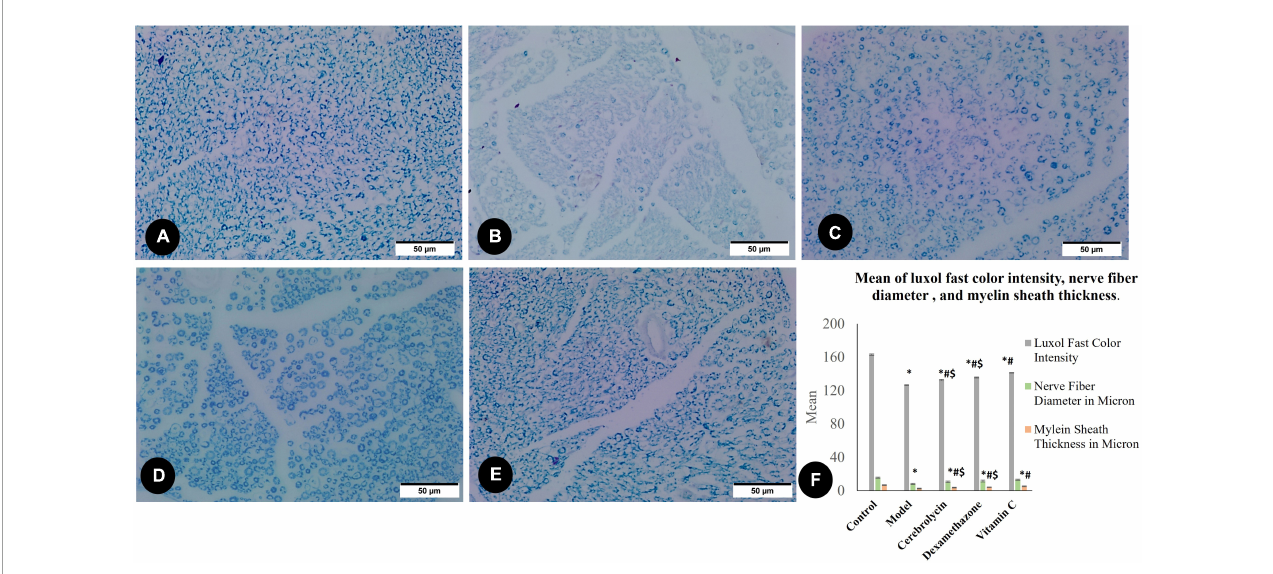
FIGURE4 Luxol fast blue staining myelin sheet in the control group (A) , the model group (B) , the Cerebrolysin group (C) , the dexamethasone group (D) , and the vitamin C group (E) . (F) Histogram illustrates a comparison of the Luxol fast color intensity, myelin sheath thickness in microns, and nerve fiber diameter in microns between different groups. *Significance as compared to control, # significance as compared to the model, and $ significance as compared to Vit C group.